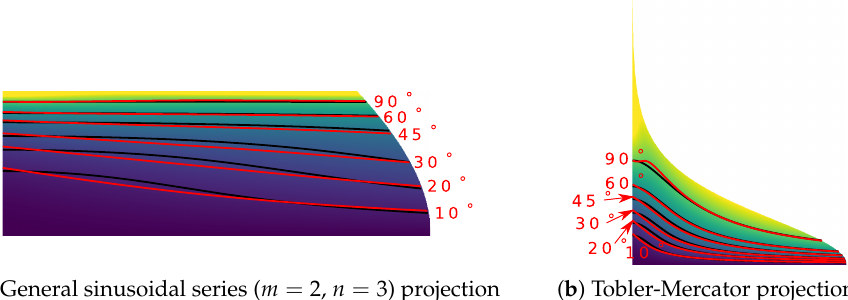
Figure 14. Distribution and contours (in red) of FWD–GCA metric for evaluating angular distortions of map projections whose errors are statistically